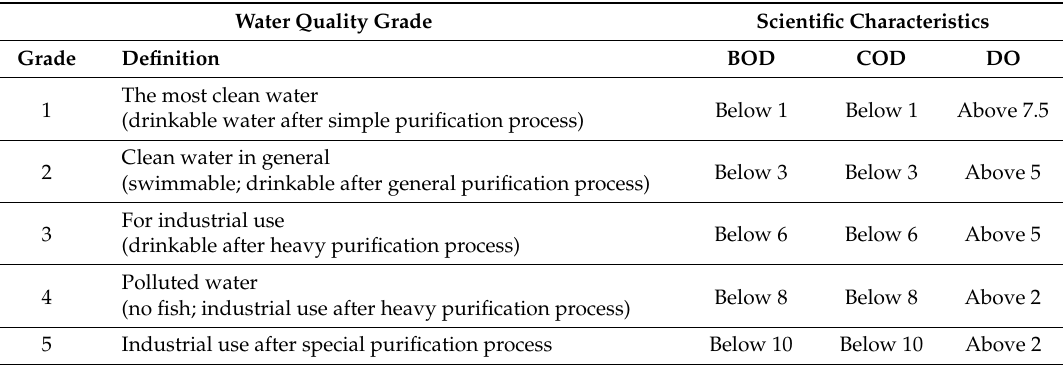
Table 1. Definition and relationship between water quality grade and scientific